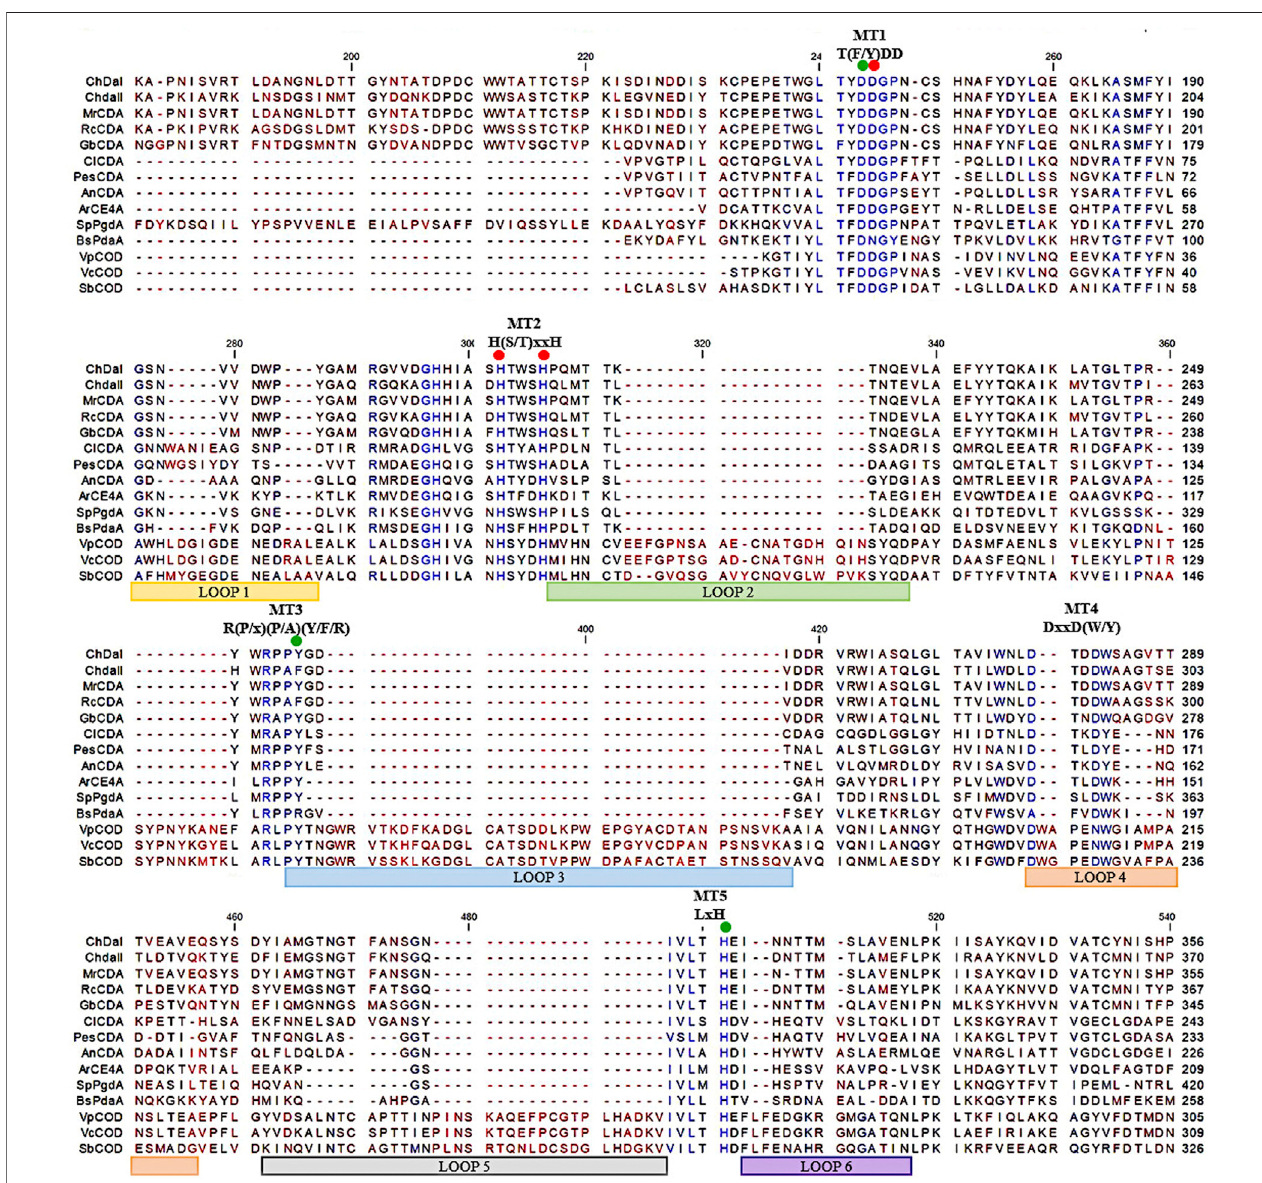
FIGURE2| MultiplesequencealignmentofchitindeacetylasesChDaIandChDaIIfrom Mucorcircinelloides IBT-83.Abbreviations:chitindeacetylasesfrom: Mucor rouxii MrCDA (Uniprot: P50325), Rhizopus circinans RcCDA (Uniprot: A7UMZ0), Gongronella butleri GbCDA (Uniprot: Q8J2N6), Colletotrichum lindemuthianum ClCDA (PDB: 2IW0), Pestolotiopsis sp. PesCDA (GenBank: APH81274.1), Aspergillus nidulans AnCDA (PDB: 2Y8U); CE4 deacetylase from marine environment Arthrobacter sp. ArCE4A (PDB: 5LGC); peptidoglycan deacetylase from Streptococcus pneumoniae SpPgdA (PDB: 2C1G); CE4 esterase from Bacillus subtilis BsPdaA (PDB: 1W17); chitooligosaccharides deacetylases from Vibrio parahaemolyticus VpCOD (PDB: 3WX7), Vibrio cholerae VcCOD (PDB: 4NY2), Shewanella woodyi SbCOD (GenBank: